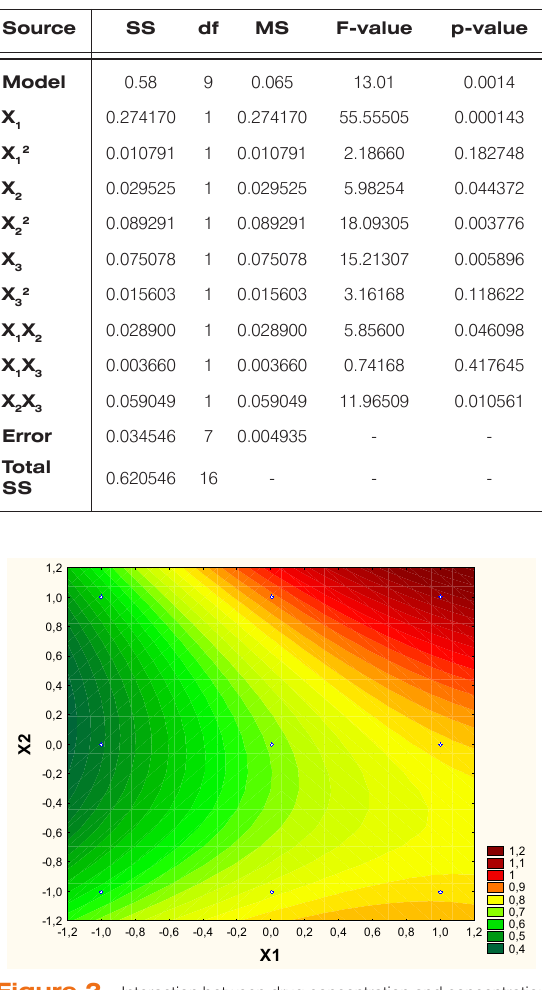
Figure 2. Interaction between drug concentration and concentration X of glycerol ( X 1 2